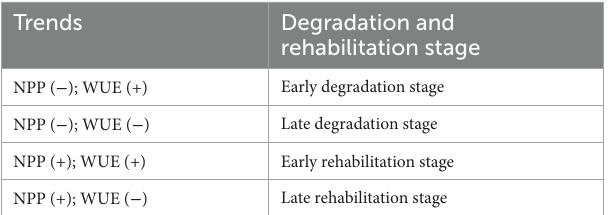
TABLE 3 Assumptions of NPP and WUE trends in various stages of vegetation degradation and restoration.